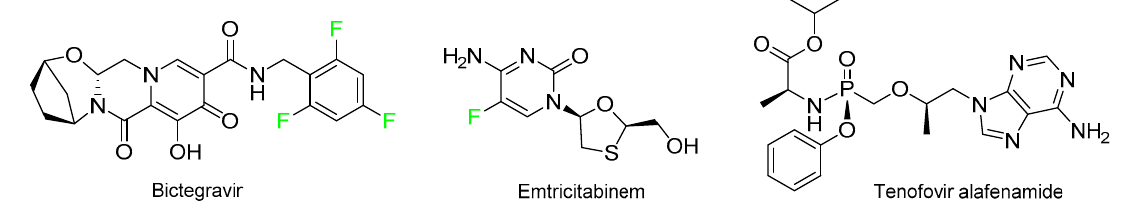
Figure 9. Structure of Biktarvy ™ , a drug combination.